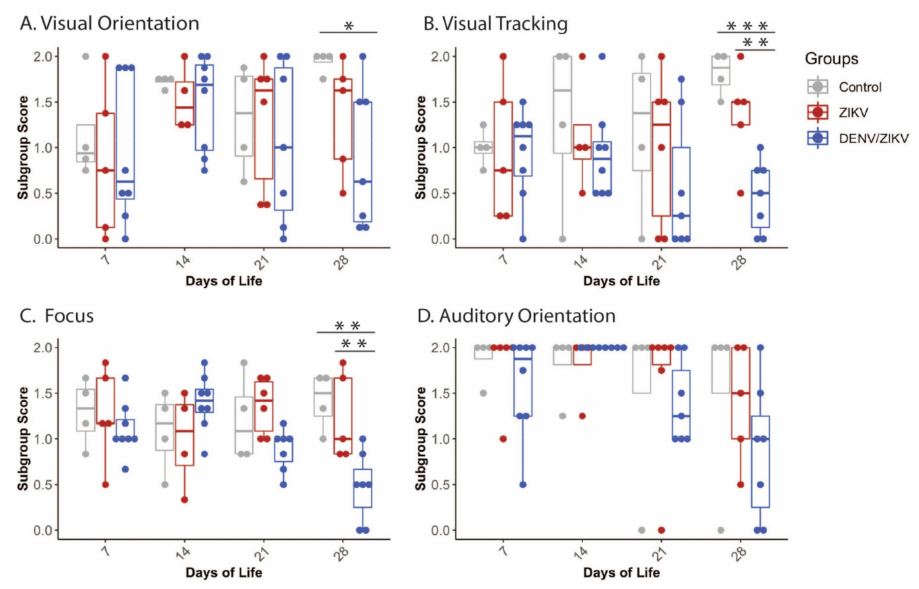
Figure 3. Neonatal neurodevelopment in the orientation domain. Orientation construct was sepa- rated into a subgroup analysis of ( A ) Visual orientation, ( B ) Visual tracking, ( C ) Focus, and ( D ) Audi- tory orientation. * = p < 0.05, ** = p < 0.01, *** = p <